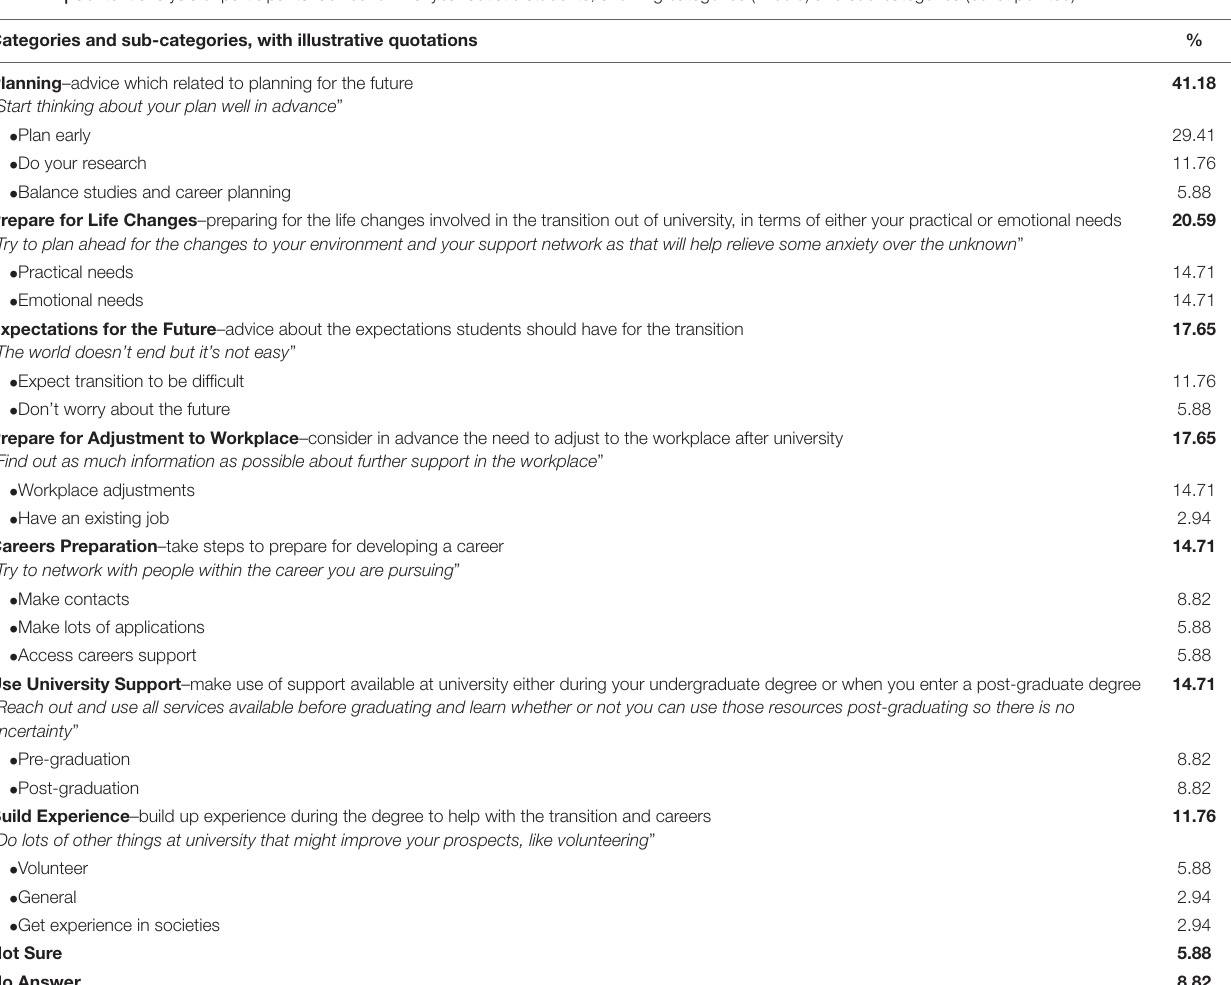
TABLE 7 | Content analysis of participants’ advice for final year autistic students, showing categories (in bold) and sub-categories (bullet pointed). Categories and sub-categories, with illustrative